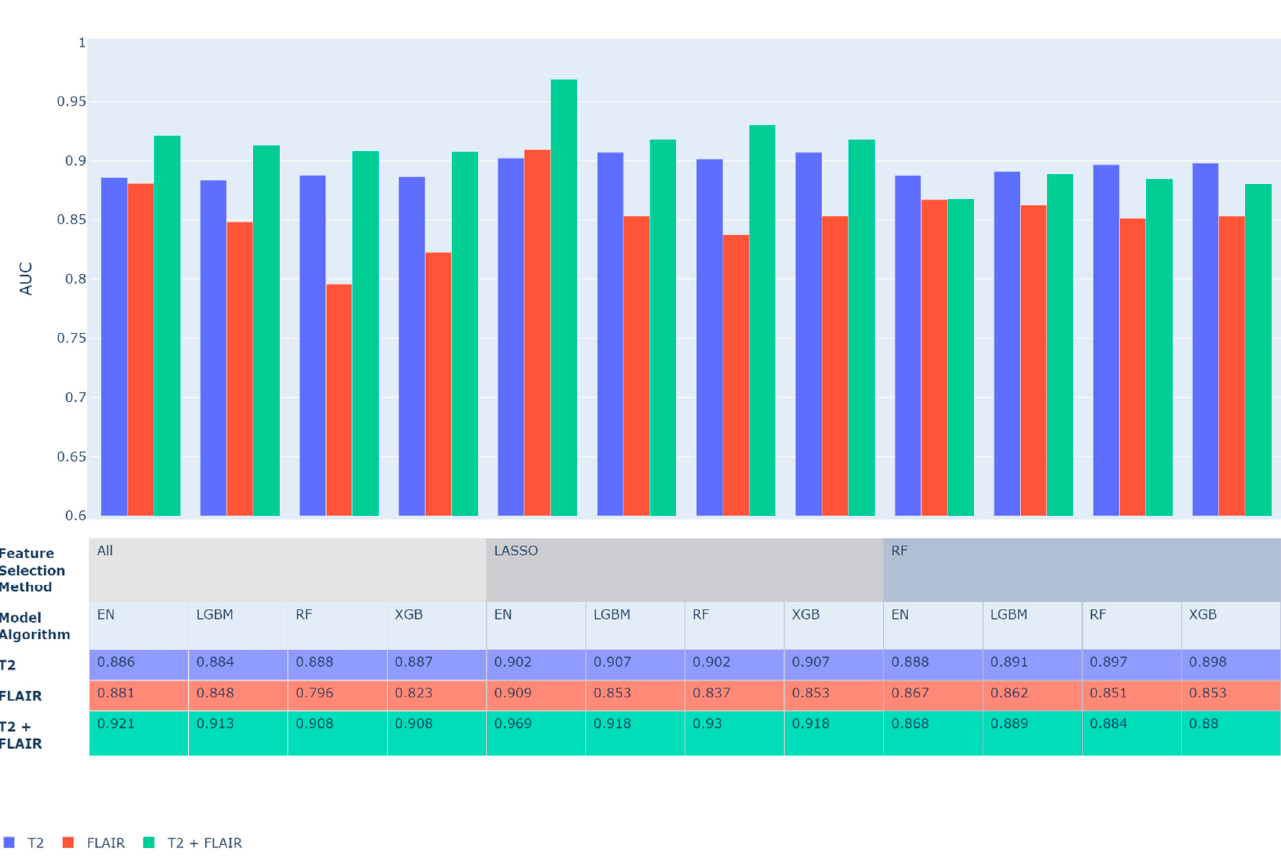
Figure 2. ML models five-fold cross-validated AUC predictive performance. LASSO and Random Forest (RF) indicate the method that was used to perform feature selection while All is used to indicate models with no feature selection (i.e., uses all features).